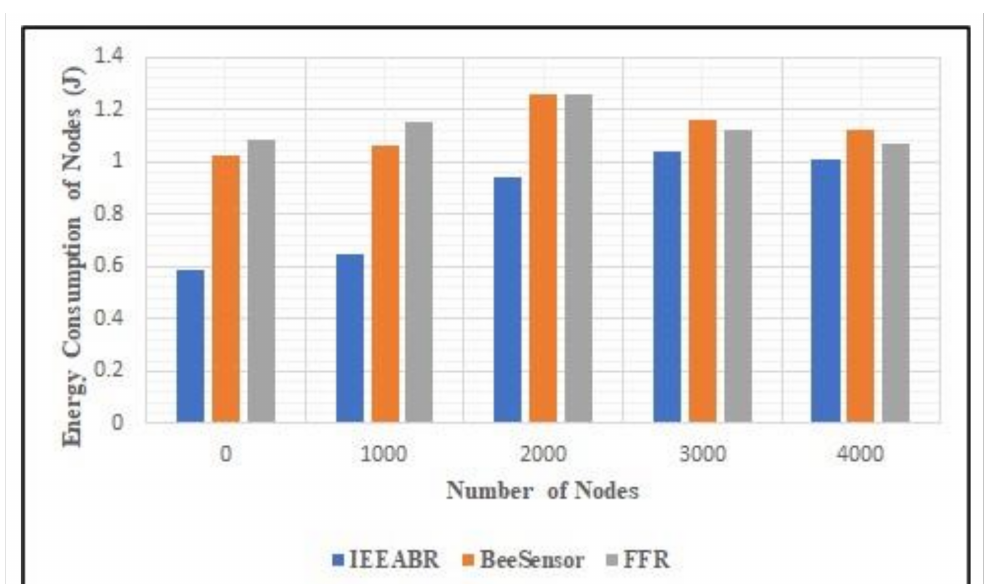
Figure 13. Energy consumption of